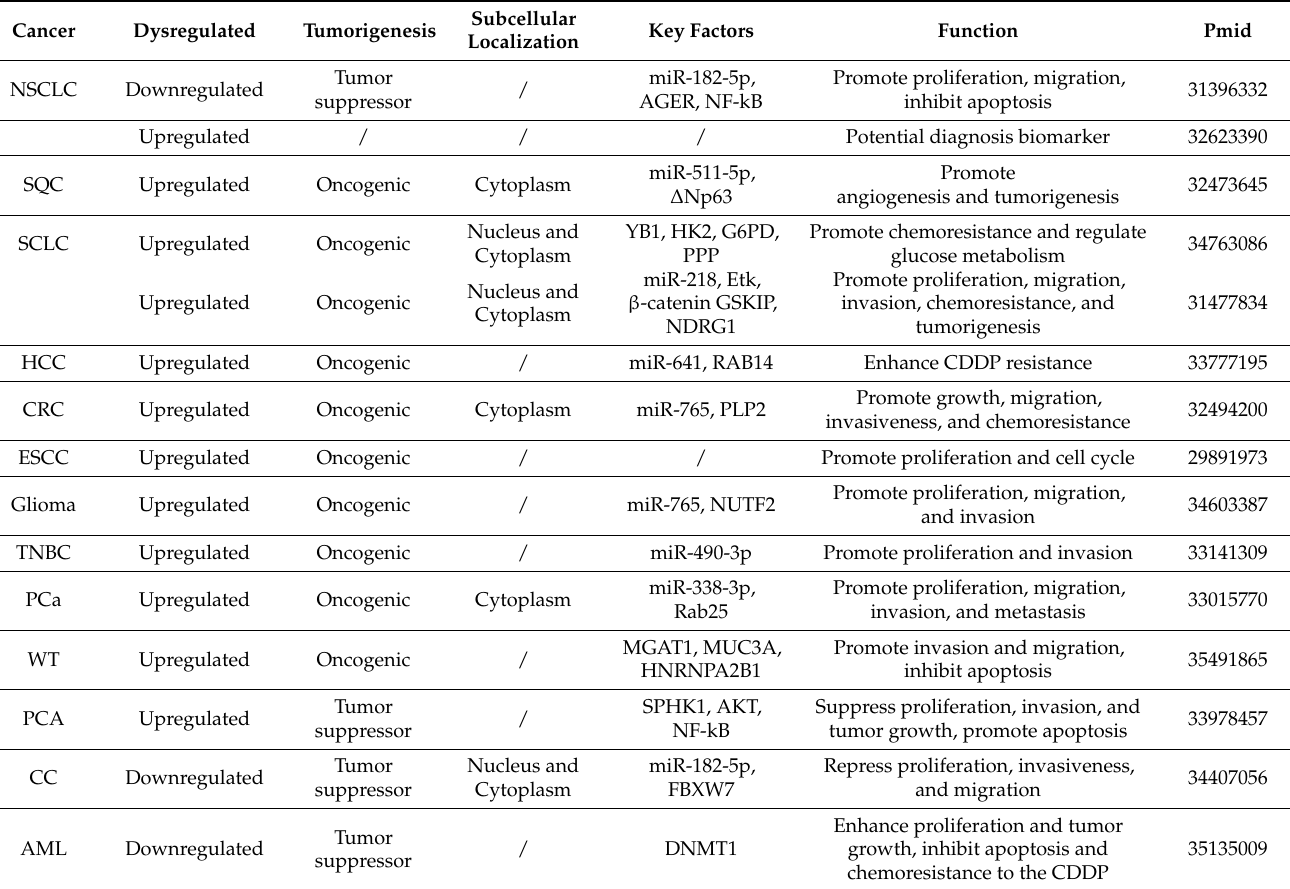
Table 1. LINC00173 is dysregulated in multiple cancers and its